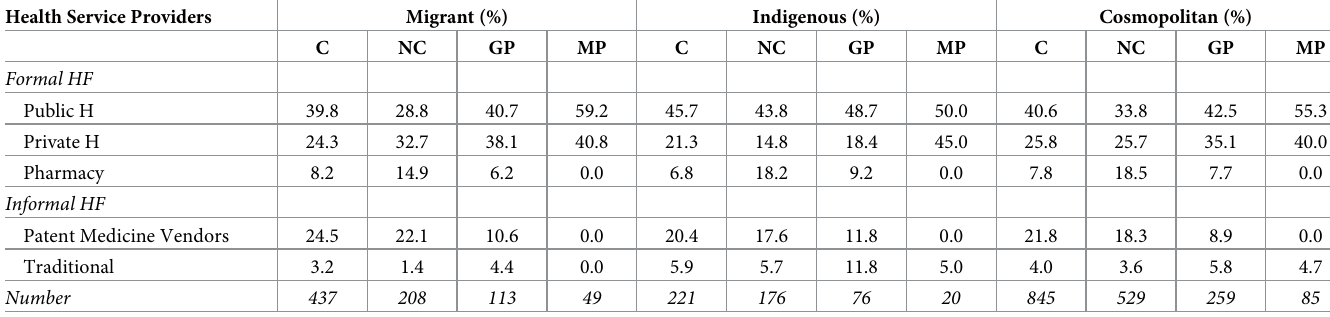
Table 3. Medical complaints at formal and informal healthcare facilities across the